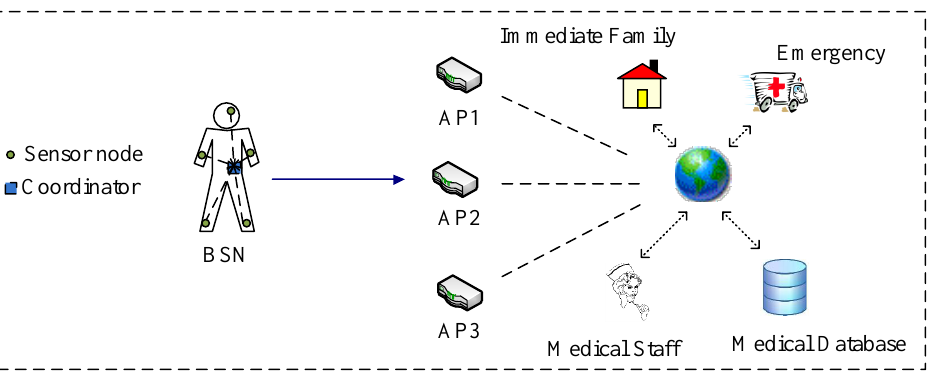
Figure 1. The common BSN